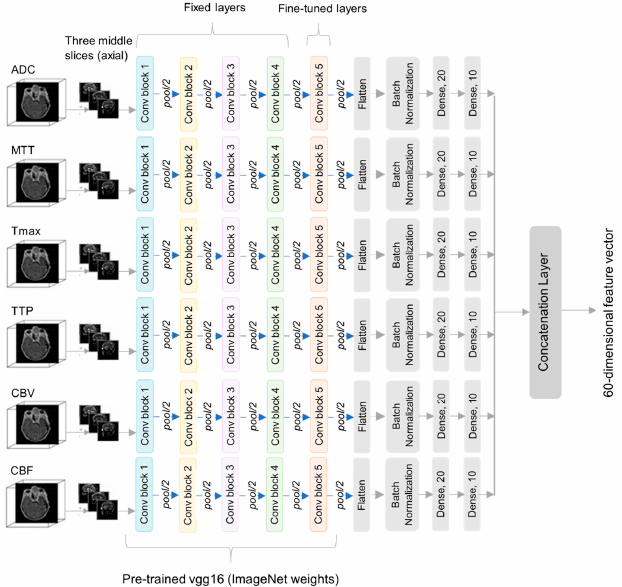
Figure 5. Details of single branch of parallel multi-parametric feature embedded siamese network (PMFE-SN).